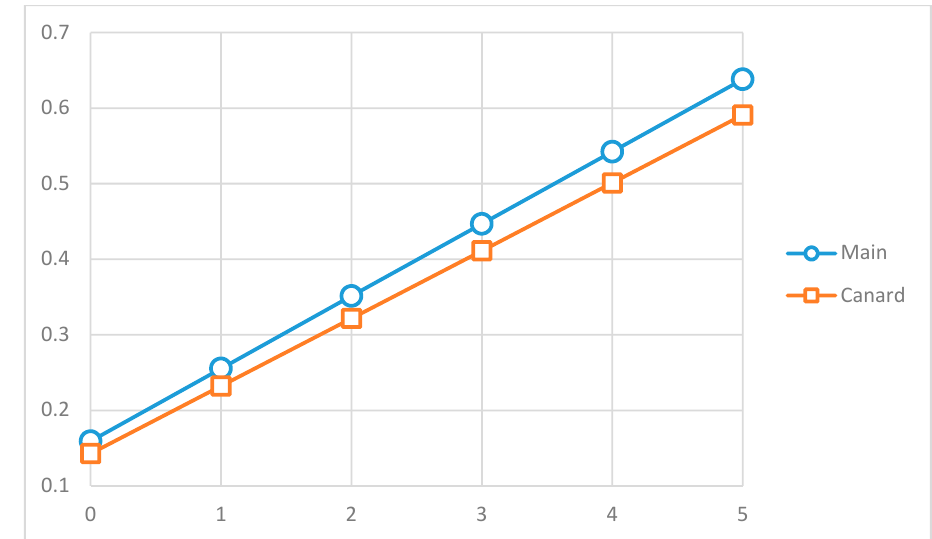
Figure 3. Main wing configuration of Vahana by using XFLR5.